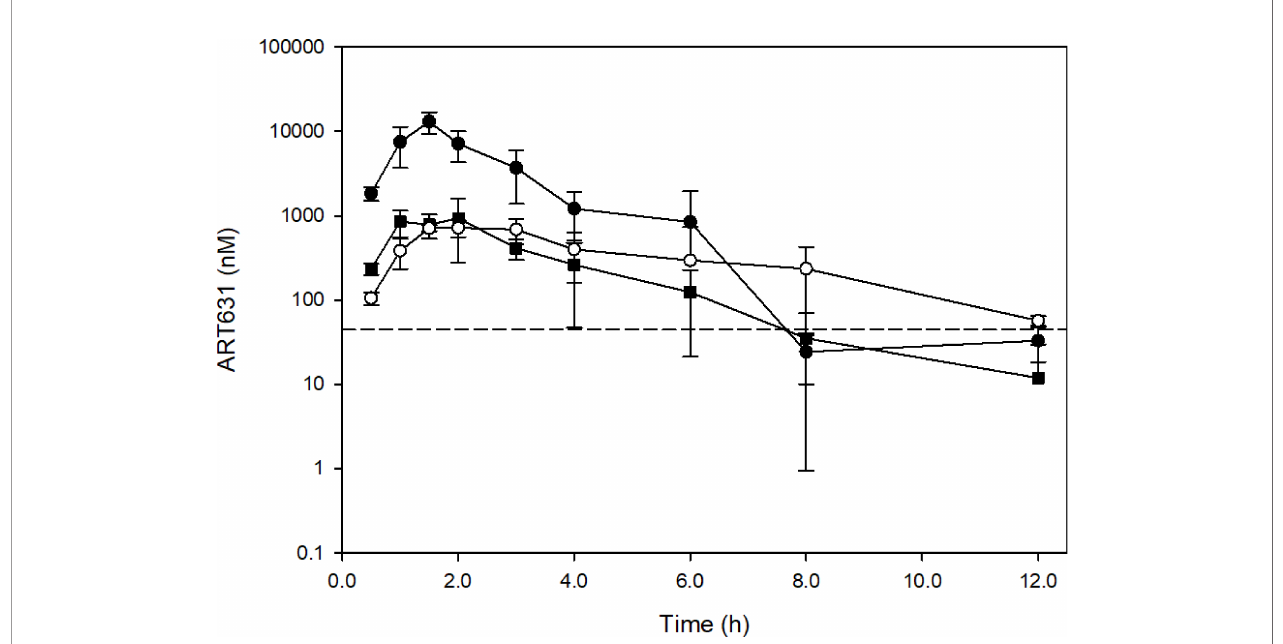
FIGURE 6 | Concentration-time pro fi les of ART631 in NRG mice (n=3) treated with single doses of 75 mg/kg PO ART631 (MTD dose; closed circle), or multiple doses of 15 mg/kg PO ART631 for 5 days (MTD dose) alone (open circle) or in the SAV combination (closed square). Plasma was obtained over 12h, with ART631 concentration determined by LC/MS-MS. Dashed line represents the highest in vitro IC 50 of ART631 (45 nM). Data points and error bars represent mean and SD of 3 replicates,